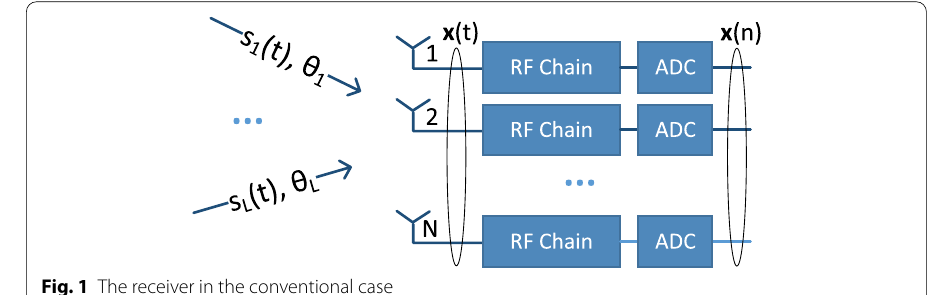
Fig. 1 The receiver in the conventional case